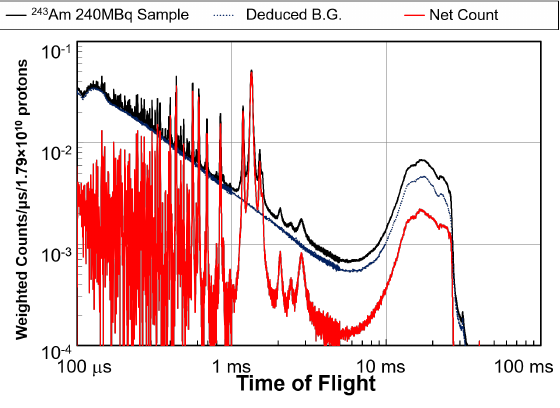
Figure 6. Deduced background and TOF spectrum of 243 Am sample before and after the background subtraction.